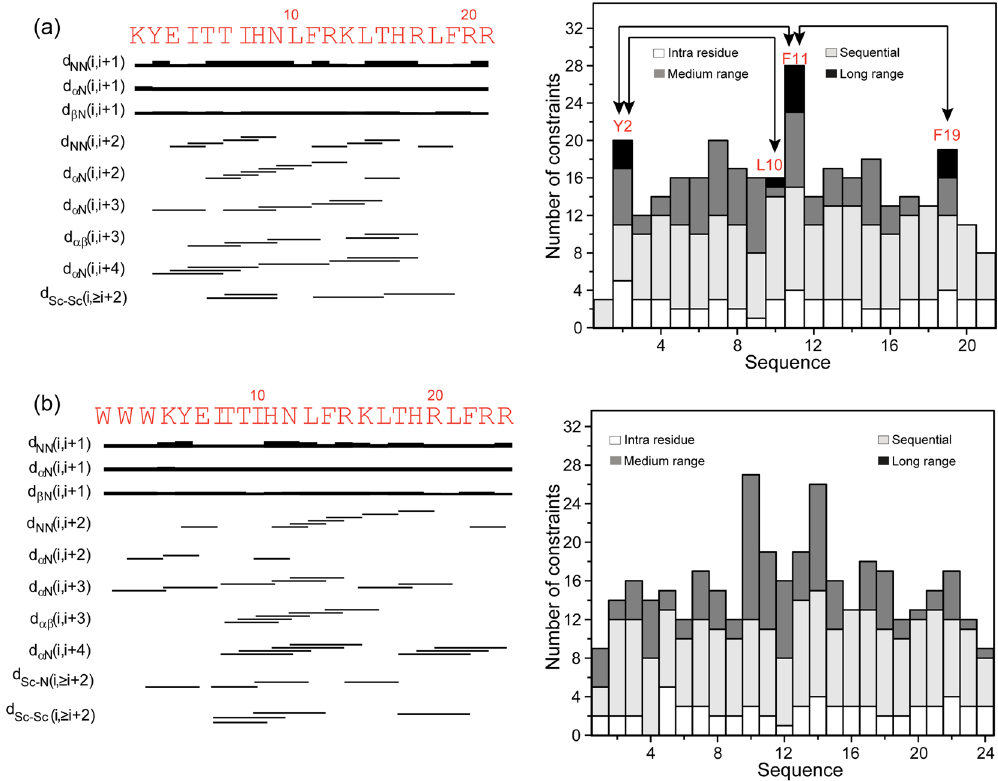
Figure 5. Structural parameters of KYE21 and WWWKYE21 in LPS. Bar diagram (left panel) and histogram (right panel) of ( a ) KYE21 and ( b ) WWWKYE21, showing important long-range and medium-range α N (i, i + 2/i + 3/i + 4), as well as long range-NOE contacts (i, ≥ i + 5) among the backbone-backbone and backbone- side chain resonances found in the trNOESY spectra, used to calculate the bound conformation of the peptides. The bar thickness in the bar diagrams corresponds directly to the NOE intensities. The primary amino acid sequences are provided at the top of the bar diagrams. The histogram depicts the number of NOE constraints used to calculate the bound conformation of the peptides as a function of residue number. The arrowheads in the histogram mark the residues that share long-range contacts with each